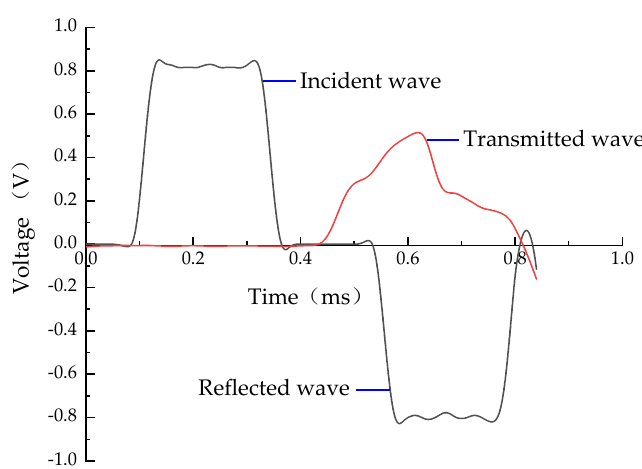
Figure 4. Typical original waveform.